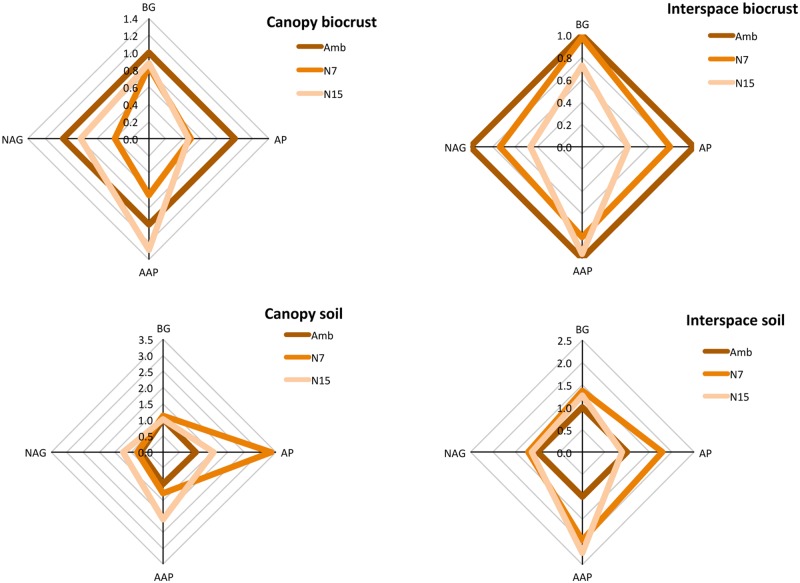
Relative responses of soil ecoenzyme activity to N treatment for biocrusts (0.5 cm) and bulk soil (0–10 cm). BG: β-1,4-glucosidase, AP: alkaline phosphatase, AAP: alanine aminopeptidase, NAG: β-1,4-N-acetylglucosaminidase.